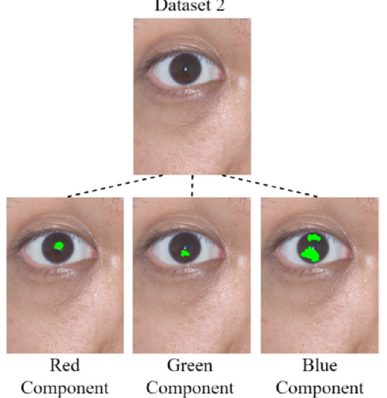
Figure 22. Image from Data Set 1.